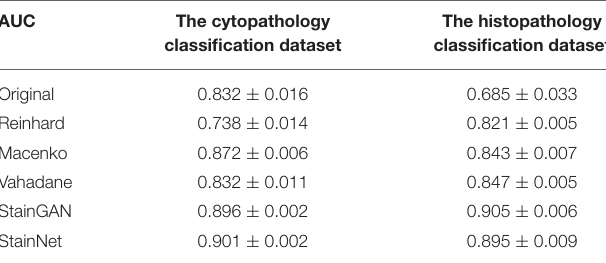
TABLE 3 | The AUC for various stain normalization methods on the cytopathology and the histopathology classification dataset. AUC The cytopathology classification dataset